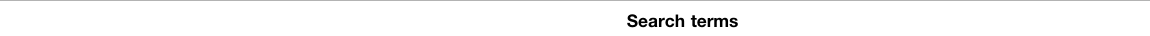
Table A1 | Search strategy used for PubMed (from inception to September